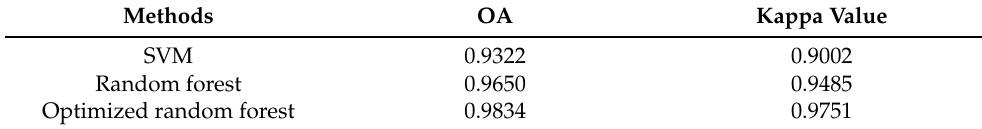
Table 4. A comparison between different methods using OA and kappa value (full bands features).